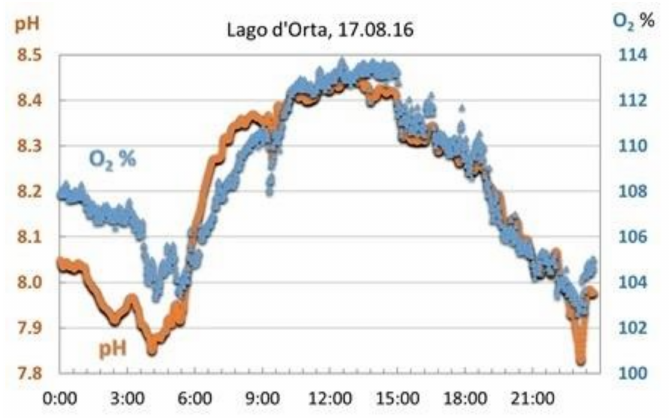
Figure 7. Example of how the high-frequency collection of limnological parameters can increase the degree of knowledge of the responses of a lake ecosystem. Graph shows hourly fluctuation of pH and